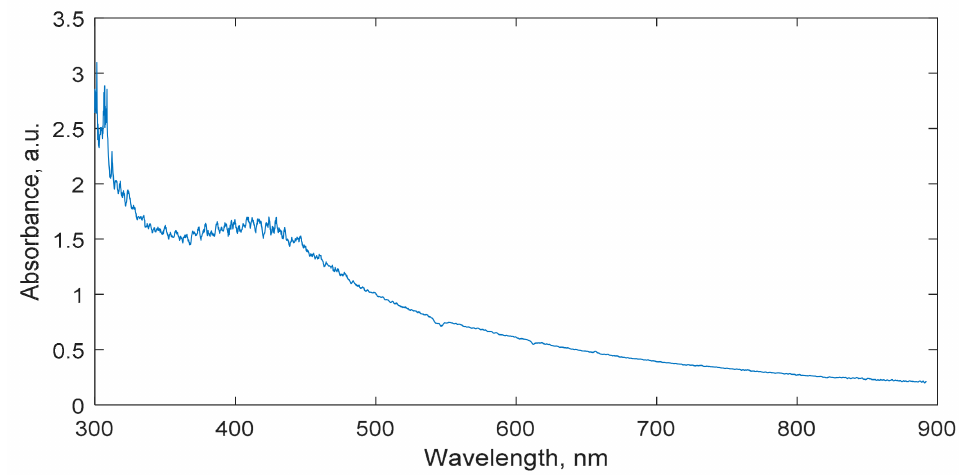
Figure 7. UV-Vis spectrum of nMAG gel dosimeter enriched with Ag nanoparticles with indicated and clearly seen plasmon resonance peak at 410